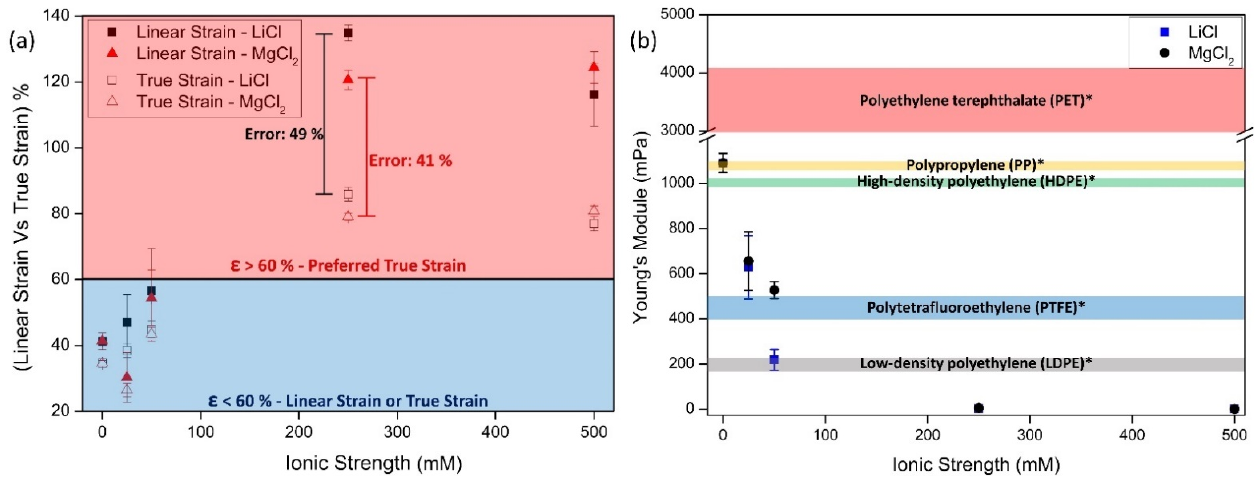
Figure 4. Linear Strain and True Strain results of MC-based films with IS of 0, 25, 50, 250, and 500 mM due to LiCl or MgCl 2 addition ( a ). YM results from MC-based films and other conventional commodity plastics (PET, PP, HDPE, LDPE, and PTFE) ( b ). * Young’s modulus values of conven- tional plastics according to Callister and Rethwisch [39]. plastics according to Callister and Rethwisch